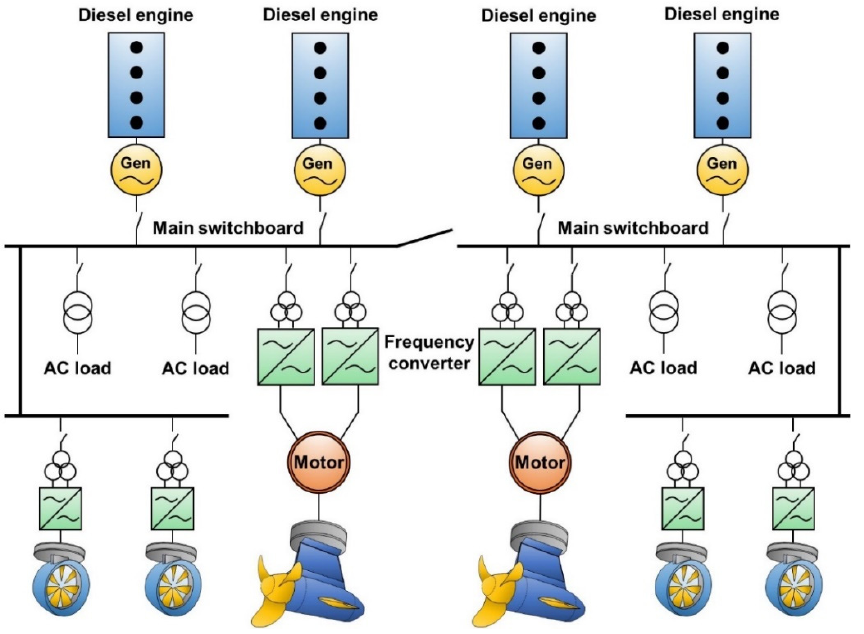
Figure 1. Typical integrated electric propulsion for cruise ships.